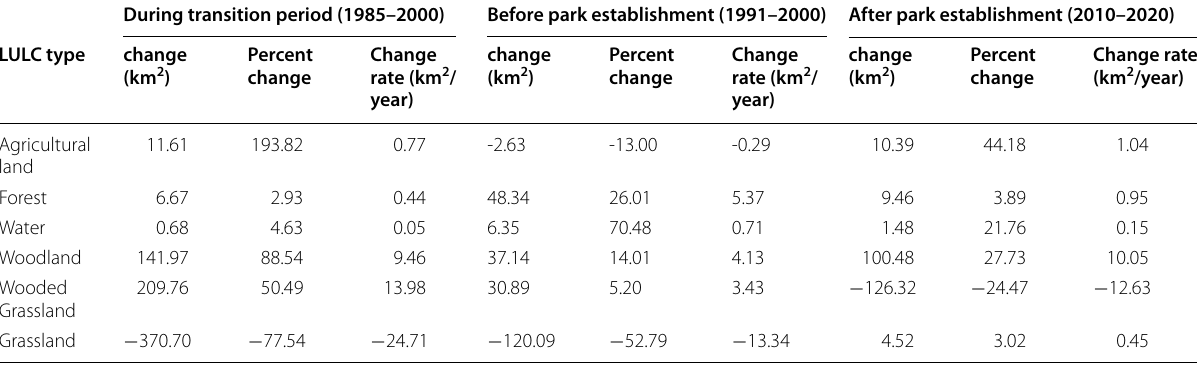
Table 2 Changes in land use land cover within Chebera Churchura National Park during transition period (1985 to 2000), before establishment (1991 to 2000) and after establishment (2010 to 2020) of the park During transition period (1985–2000)